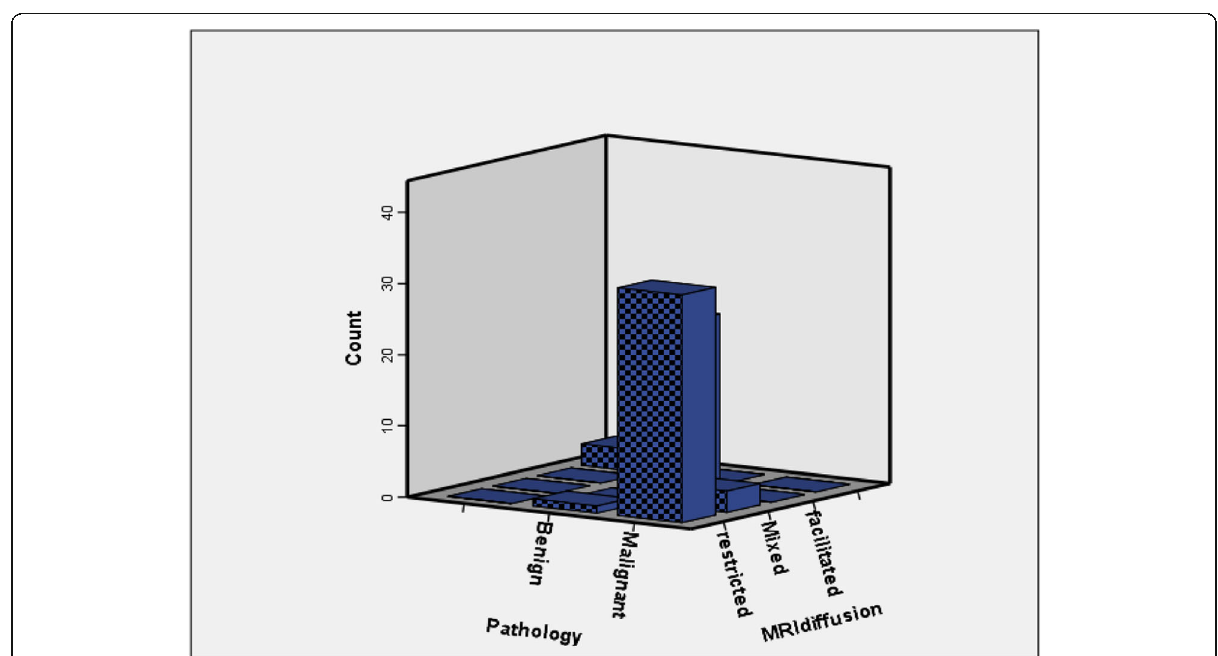
Fig. 1 Correlation between DWI and pathological